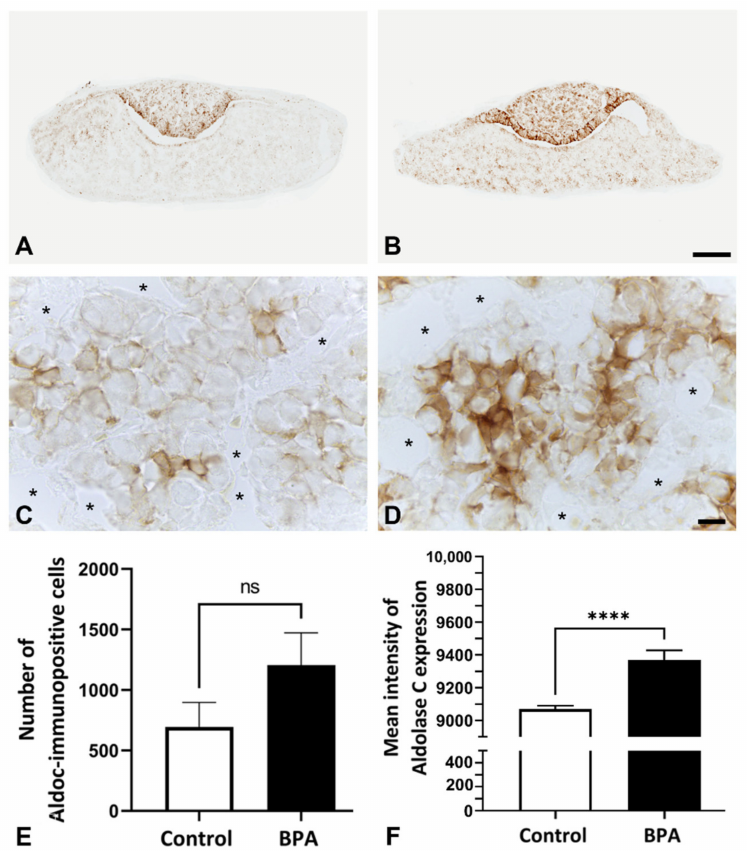
Figure 3. Immunohistochemistry of aldolase C on postnatal Day 1 in the anterior pituitary glands of control rats (( A , C ): higher magnification view of ( A )) and BPA-treated rats (( B , D ): higher magnifi- cation view of ( B )). Number ( E ) and mean intensity ( F ) of aldolase C immunopositive cells in the control and BPA-treated groups. Note: the capillary lumens (asterisks). No significant differences (ns), **** p < 0.0001. Scale bars: 100 µ m ( A , B ); 10 µ m ( C , D ).